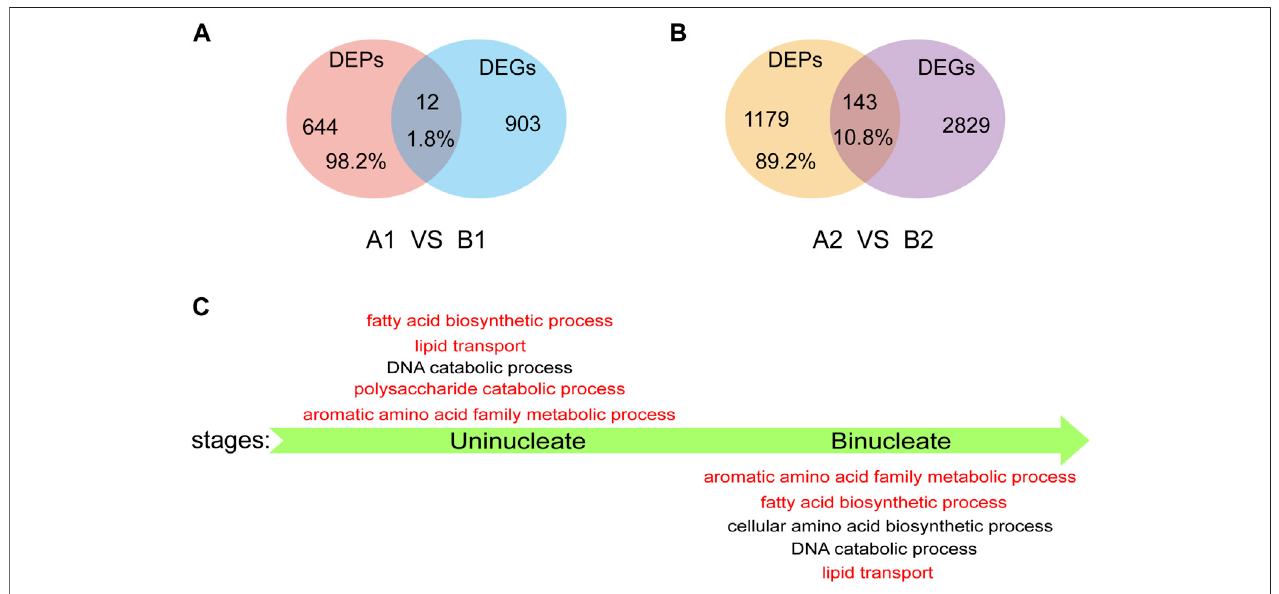
FIGURE4| AnalysisofDEPsdetectedonlybyproteomics. (A) VenndiagramsofDEPsandDEGsinuni-nucleatestage. (B) VenndiagramsofDEPsandDEGsinbi- nucleate stage. (C) GO function enrichment analysis of DEPs detected only by proteome in uni-nucleate and bi-nucleate stages.